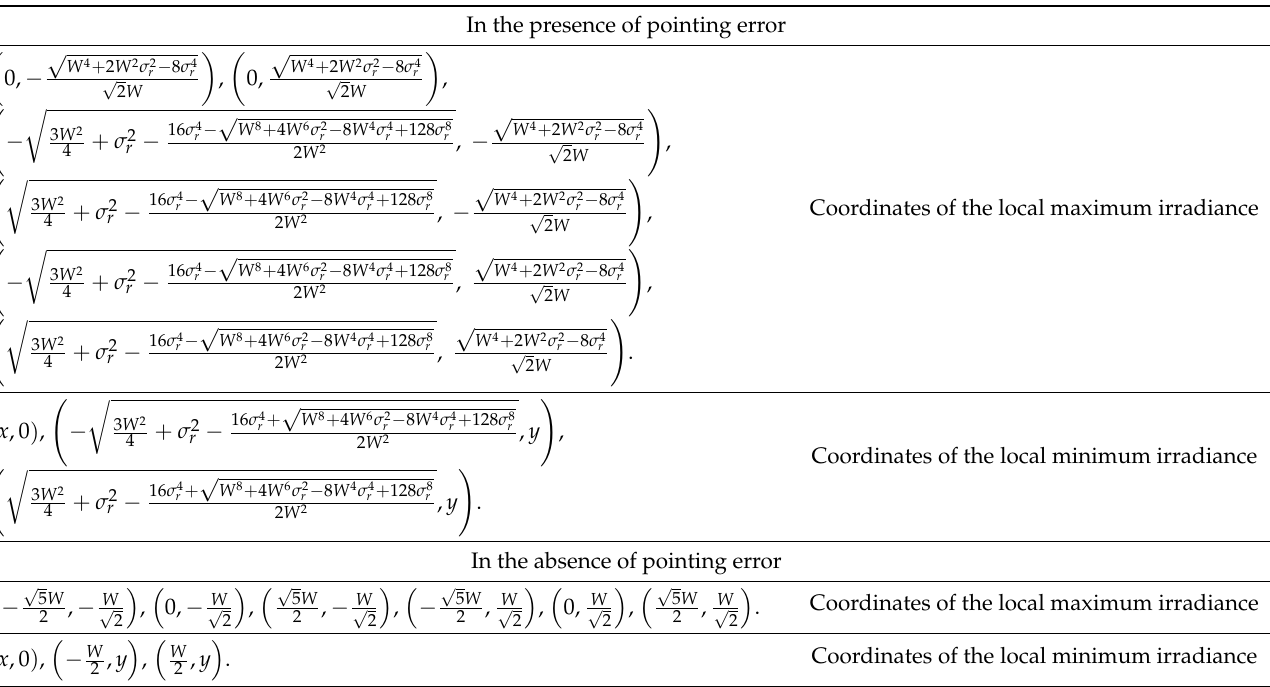
In the absence of pointing error Coordinates of the local maximum irradiance Coordinates of the local minimum